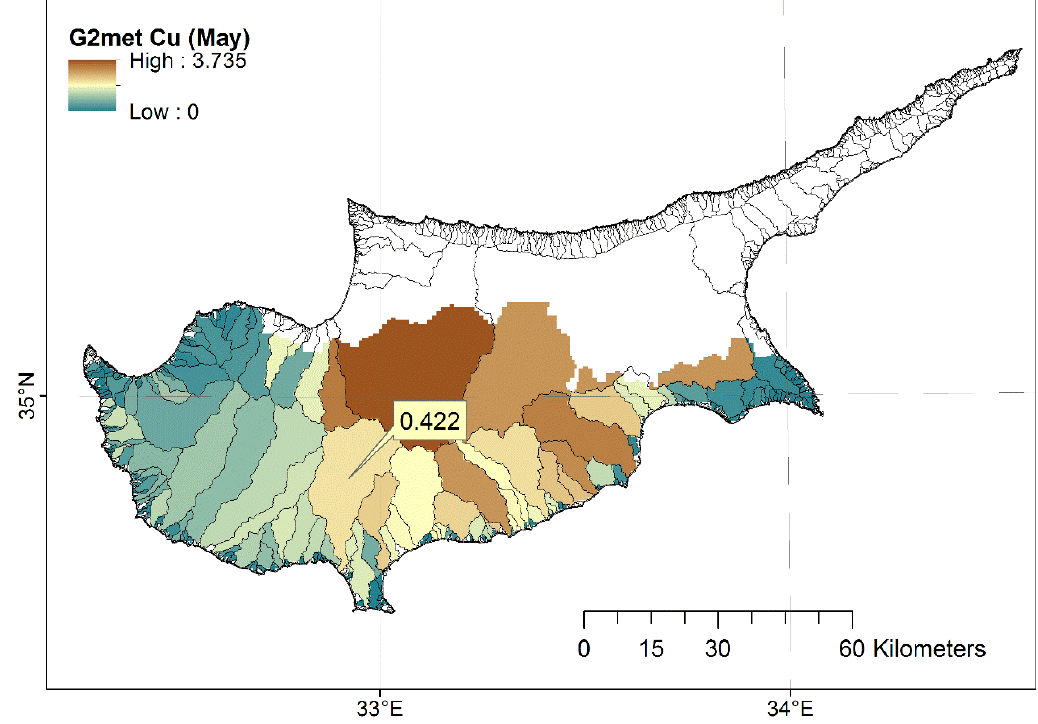
Figure 11. Choropleth map of the mean G2 met index values for Cu per basin in May (value ranging: histogram equalization; indicative example of Kouris basin,